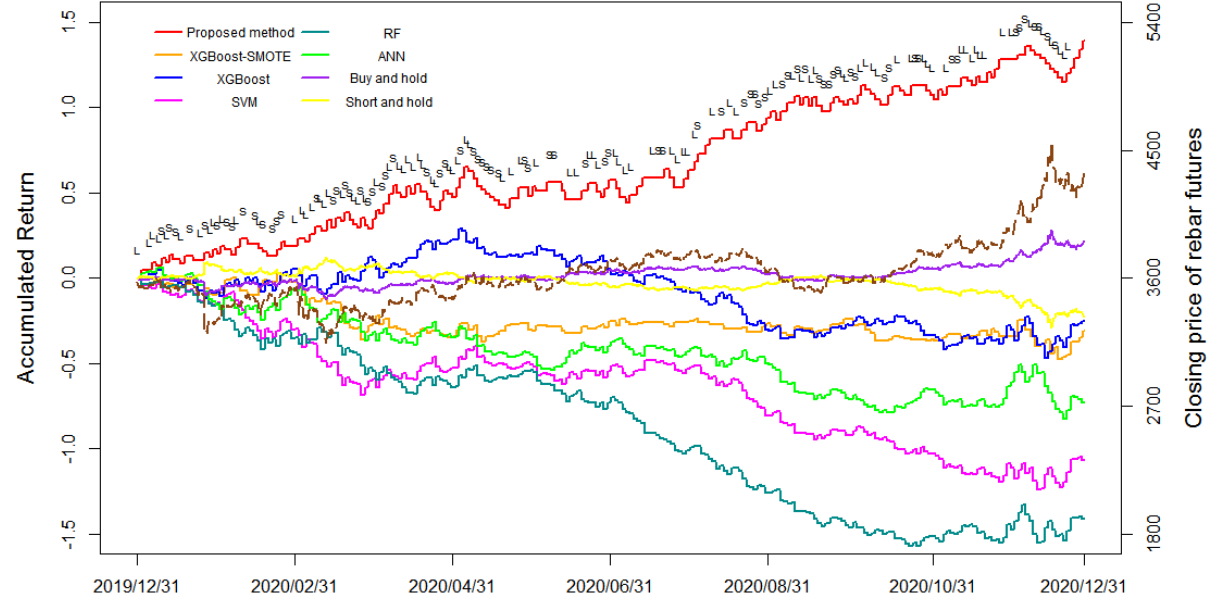
Figure 4. Accumulated returns of the proposed method and benchmarks in the entire testing pe-